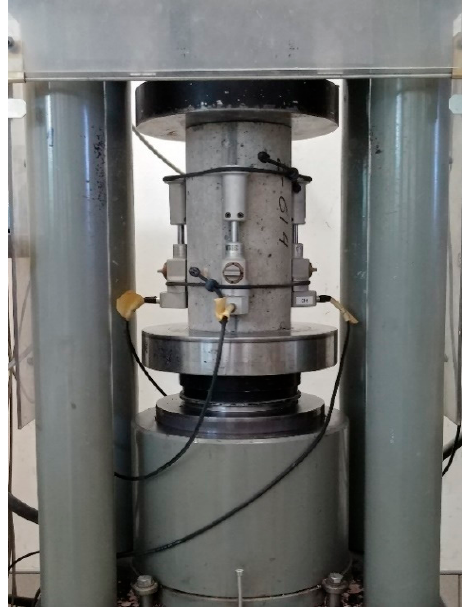
Figure 2. Modulus of elasticity